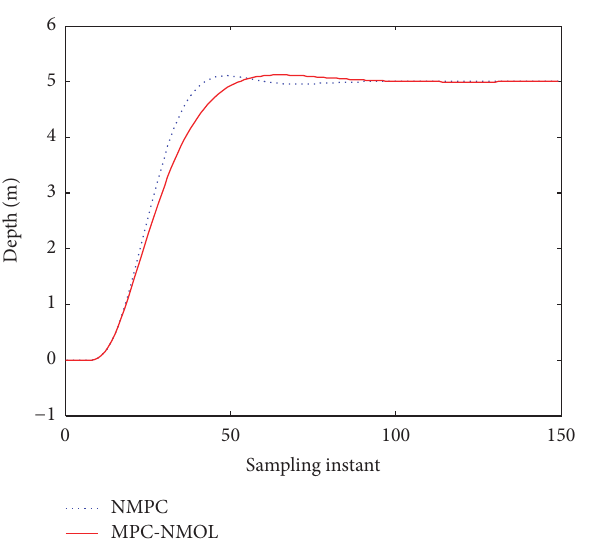
Figure 5: Comparison of pitch angle with no